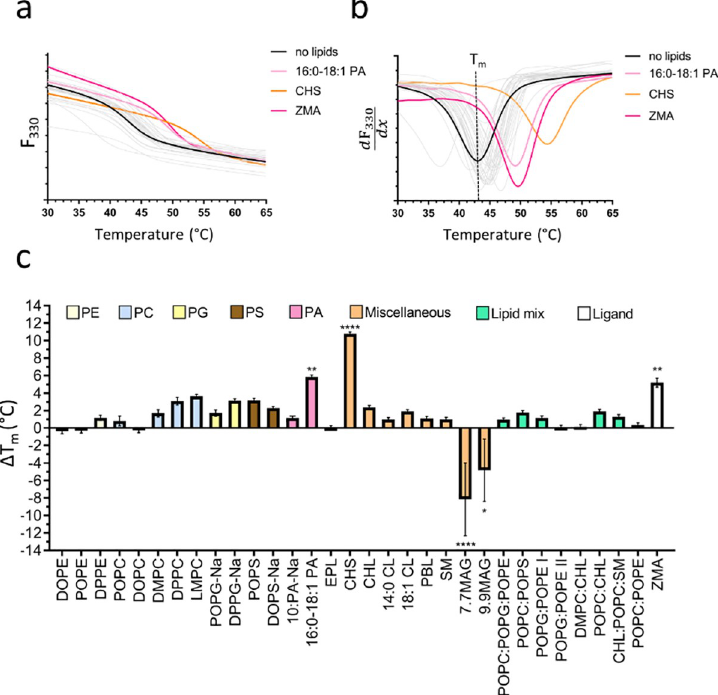
Fig 1. Lipid screening of A 2A R by nanoDSF. ( a ) F 330 signal of the no lipids reference sample (black line) and a representative set of stabilising lipids (coloured lines) during the melting scan. Grey lines show the fluorescence traces of the other tested lipids. ( b ) First derivative of the F 330 signal highlighting the fluorescence change indicative of protein unfolding. The T m can be determined at the curve peak, here shown for the no lipids reference sample as dotted line. ( c ) Δ T m of detergent-solubilised to relipidated sample shown for all tested lipids, which are sorted and colour coded according to their lipid class. Panel a-b show the traces of a representative nanoDSF scan. Panel c shows the Δ T m and corresponding standard error of the mean (SEM) based on three technical repeats. The asterixis represent the p-value ( � = 0.0332, �� = 0.021, ��� = 0.002, ���� = 0.0001) obtained by a one-way ANOVA followed by a Dunnet test to correct for multiple comparison in GraphPadPrism